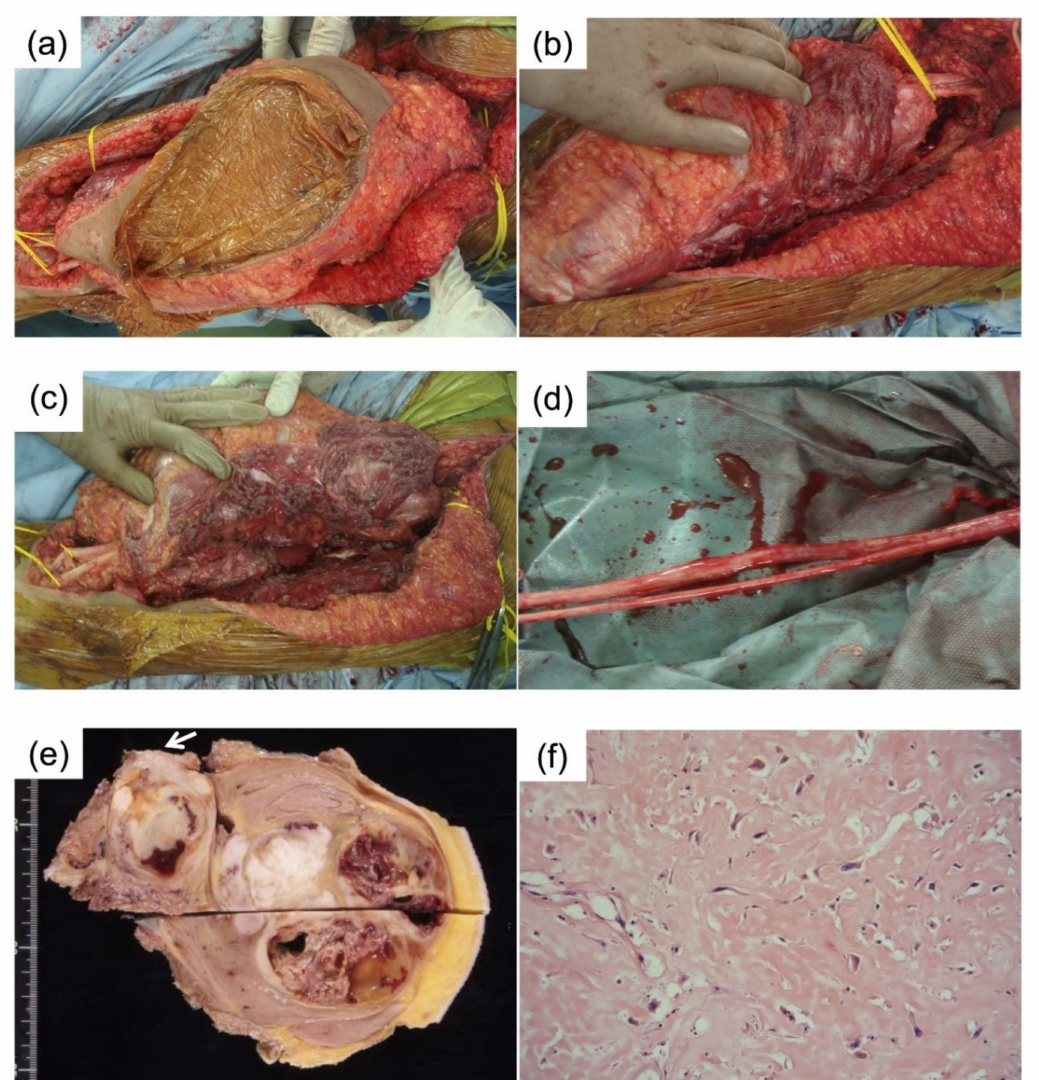
Figure 4. Surgical procedures. Wide resection of the posterior thigh muscles with the tumor was performed ( a ). In the proximal and distal regions, the sciatic nerve was exposed ( b – d ). In the area separated by the vinyl sheet, the sciatic nerve was approached from the nearest point to the surface of the tumor and released from the attached tumor. Subsequently, the nerve was treated with alcohol and distilled water. The resected specimen ( e ). The site where the sciatic nerve was originally located (white arrow). Histological image of the resected specimen (( f ), H.E. stain, 40 ×